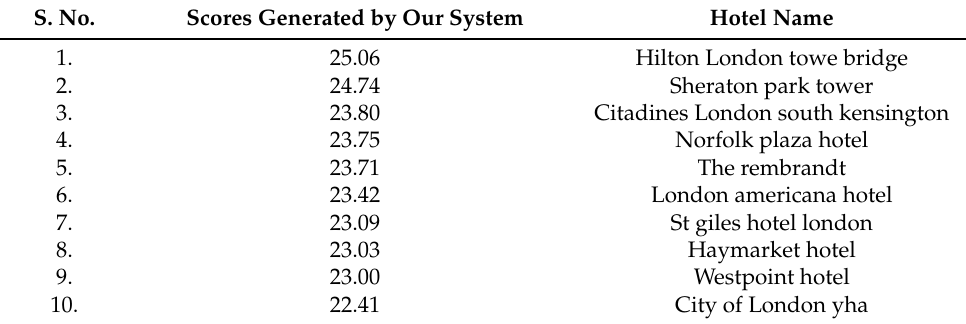
Table 14. Top-10 Hotel Recommendation Generated by Our System for the 875 Hotels of TripAdvisor.com. S. No. Scores Generated by Our